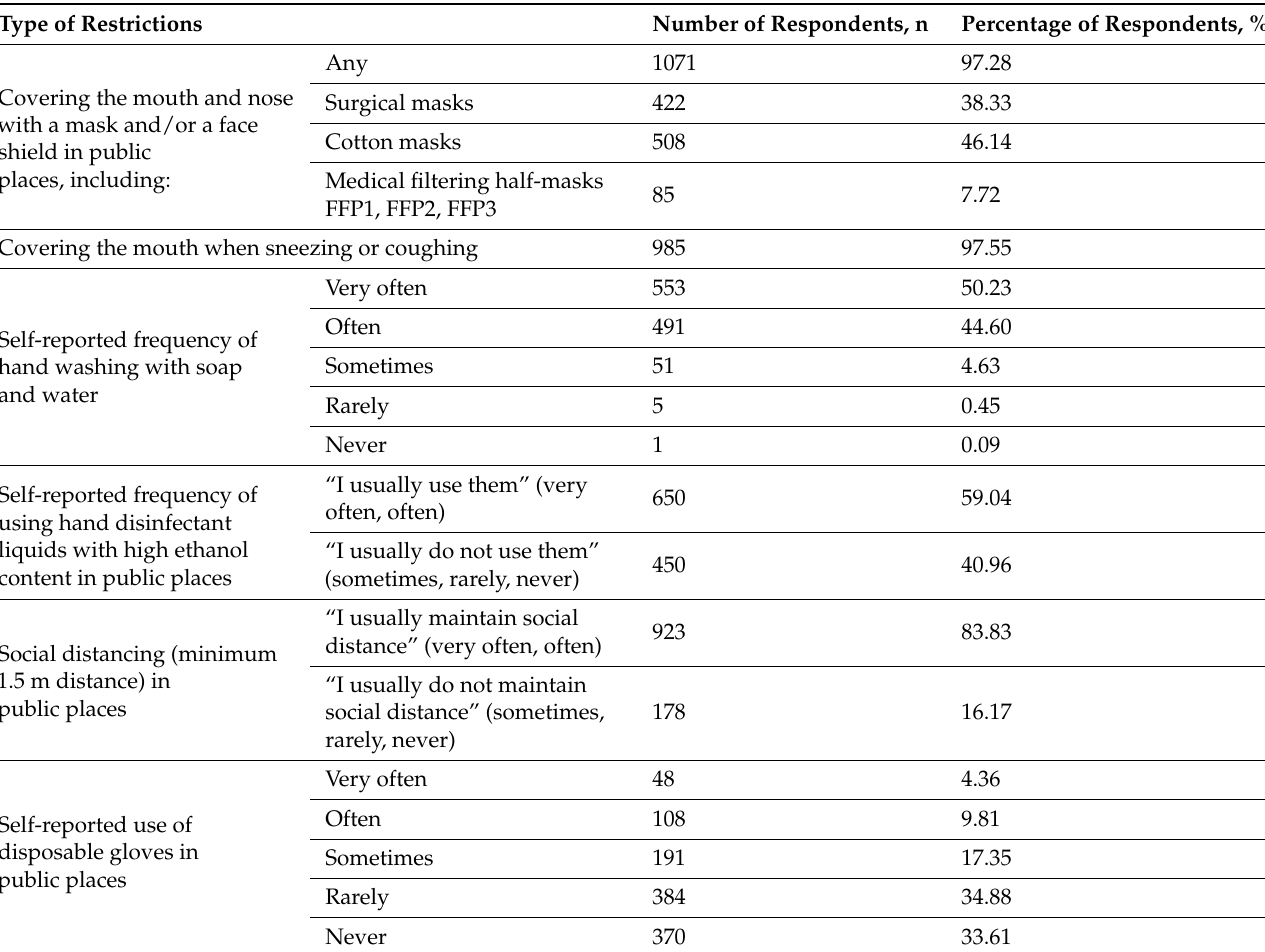
Table 2. Attitudes of Poles to restrictions during the COVID-19 pandemic.